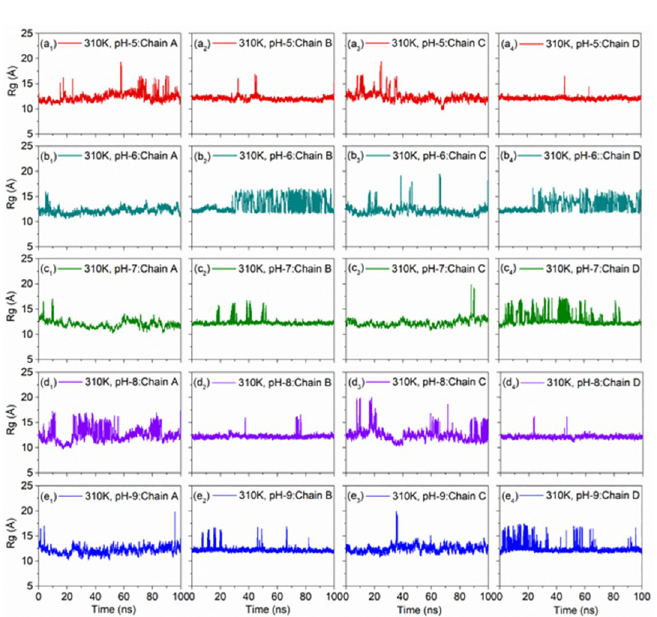
Fig 12. Variation of radius of gyration (Rg) of all the strands of the DNA Junction with simulation time at 310K with altered pH, viz. (a 1 -a 4 ) pH5, (b 1 -b 4 ) pH6, (c 1 -c 4 ) pH7 as reference, (d 1 -d 4 ) pH8, and (e 1 -e 4 ) pH9.